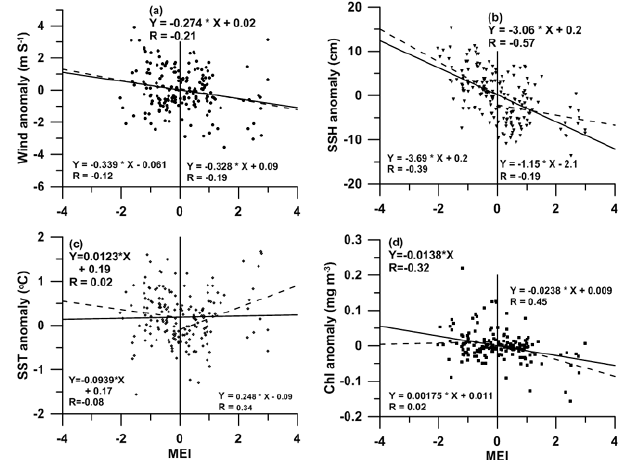
Fig. 11. Linear regression between environmental anomalies and MEI for (a) Wind speed, (b) sea surface height, (c) sea surface tem- perature and (d) sea surface chlorophyll a . The solid lines represent regression results for all conditions. The dashed lines represent re- sults for MEI negative (La Niña) or positive (El Niño)